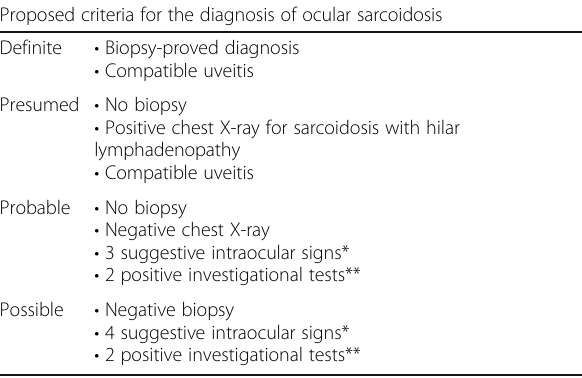
Table 2 Diagnostic criteria for ocular sarcoidosis [14] Proposed criteria for the diagnosis of ocular sarcoidosis